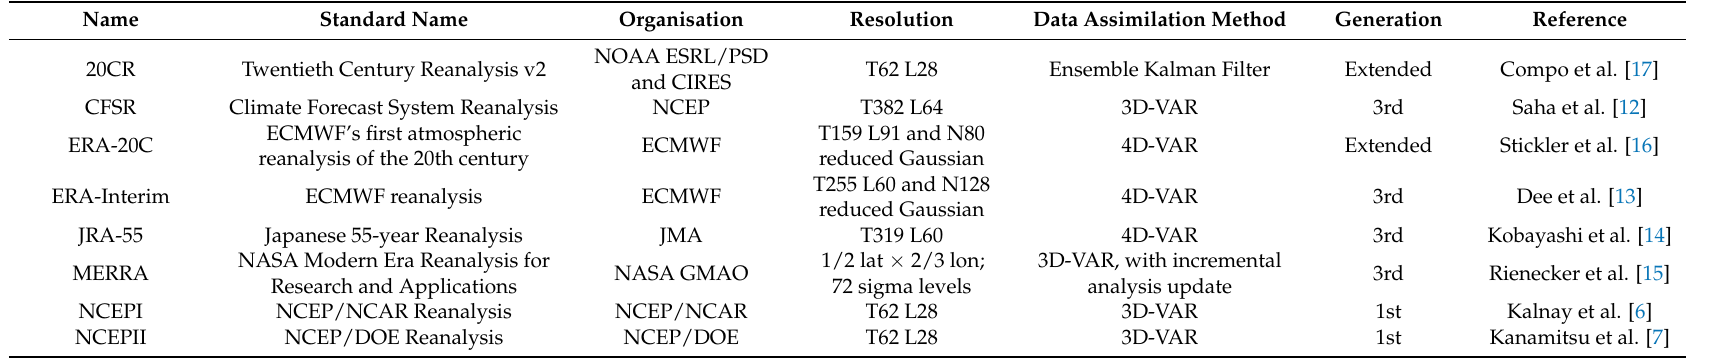
Table 1. Basic information of re-analyses investigated in this